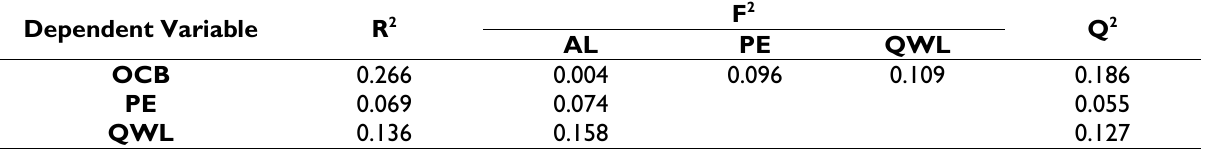
Table 4. Explained Variance. Effect Size. dan Predictive